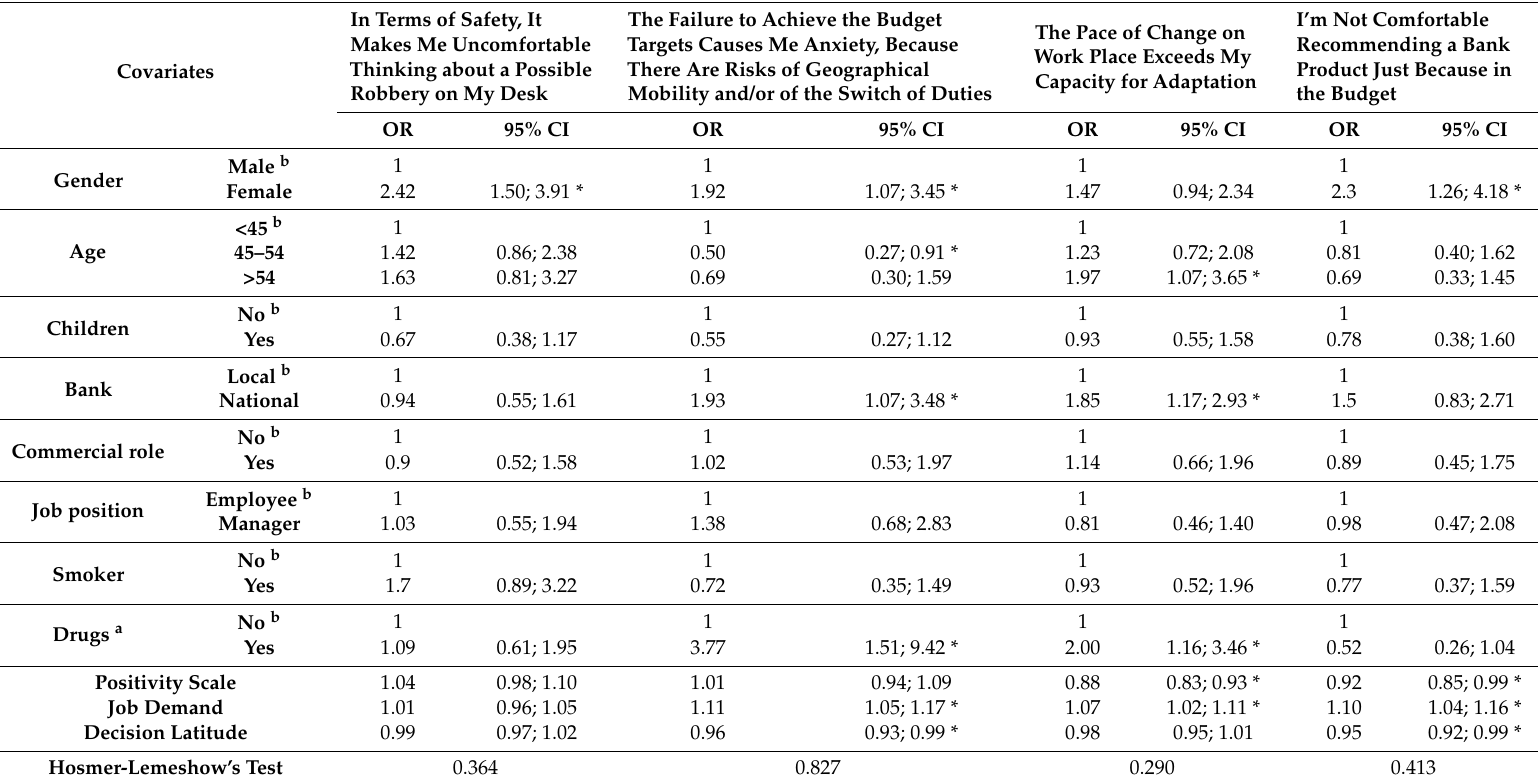
Table 3. Multivariate logistic regression models concerning the first four BEST8 (cid:48) items. In Terms of Safety, It Makes Me Uncomfortable Thinking about a Possible Covariates Robbery on My Desk